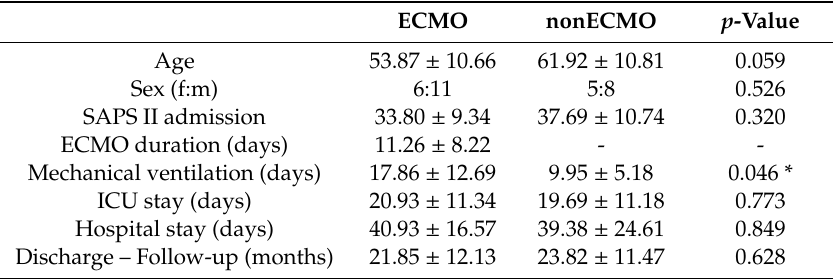
Table 1. Patient characteristics, values are displayed as mean ± standard deviation, significant di ff erences are marked *.